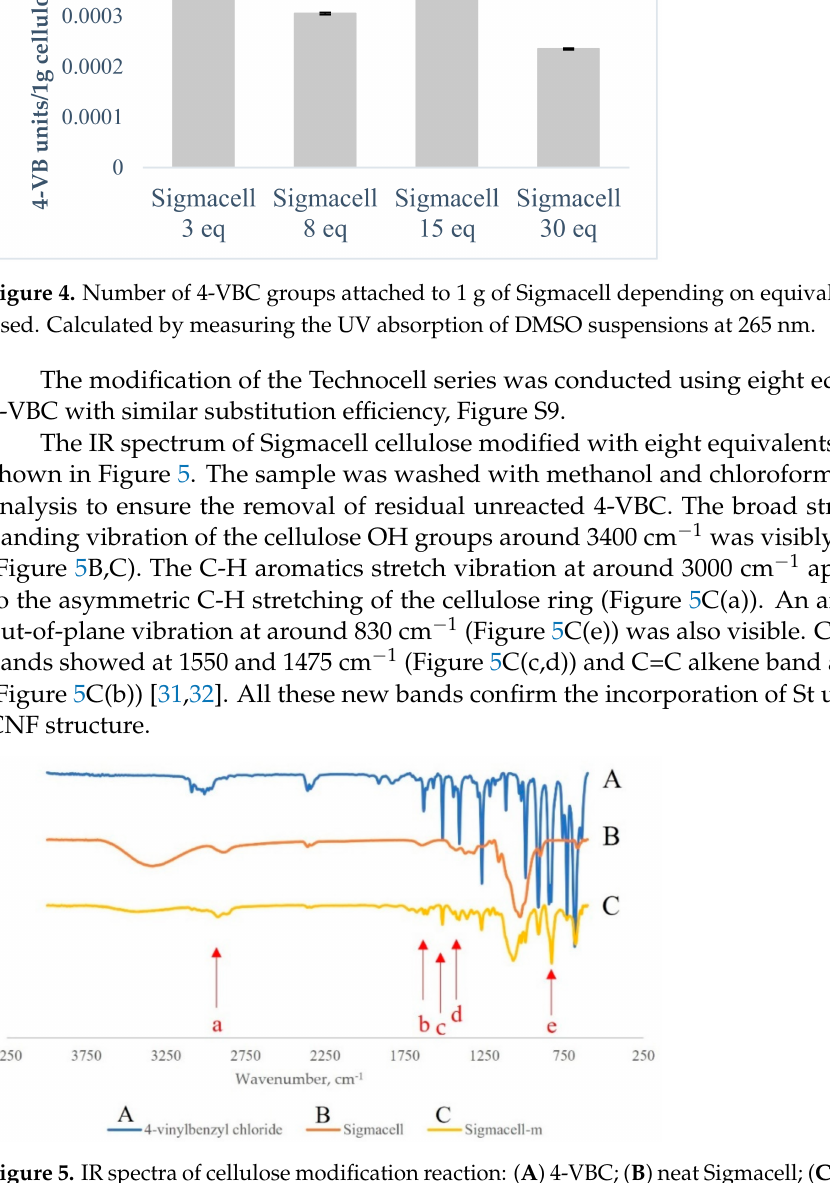
Figure 5. IR spectra of cellulose modification reaction: ( A ) 4-VBC; ( B ) neat Sigmacell; ( C )